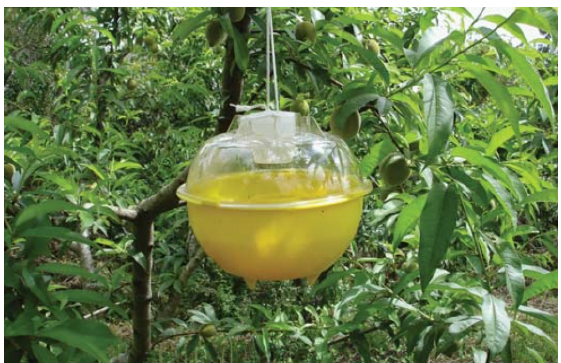
Figure 2. McPhail trap during peach orchard